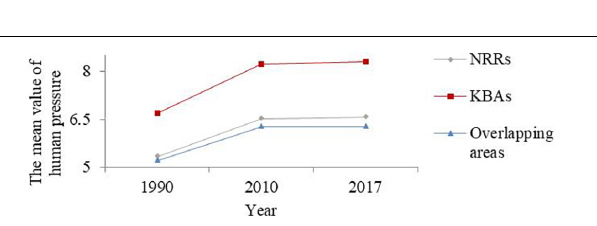
FIGURE 4 | Mean value of human pressure in NNRs and KBAs during 1990–2017.